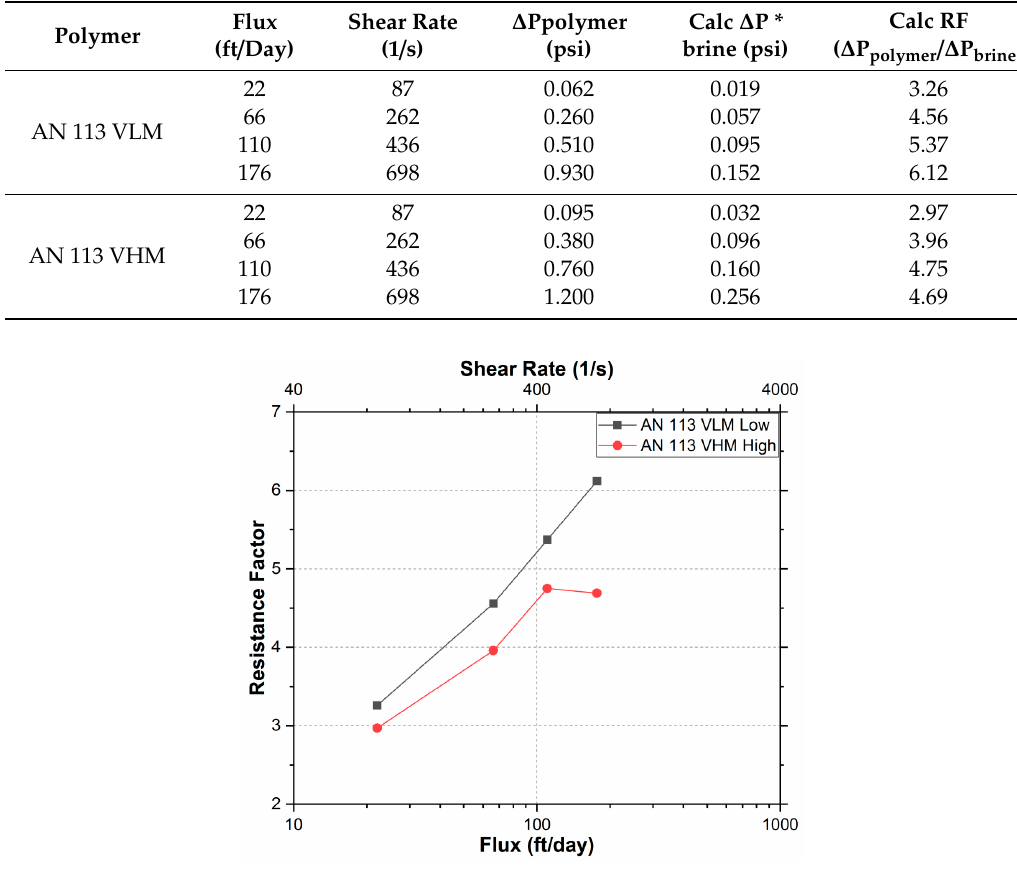
Figure 10. Rheological Behavior in porous media of AN113 VLM and AN113VHM polymers.